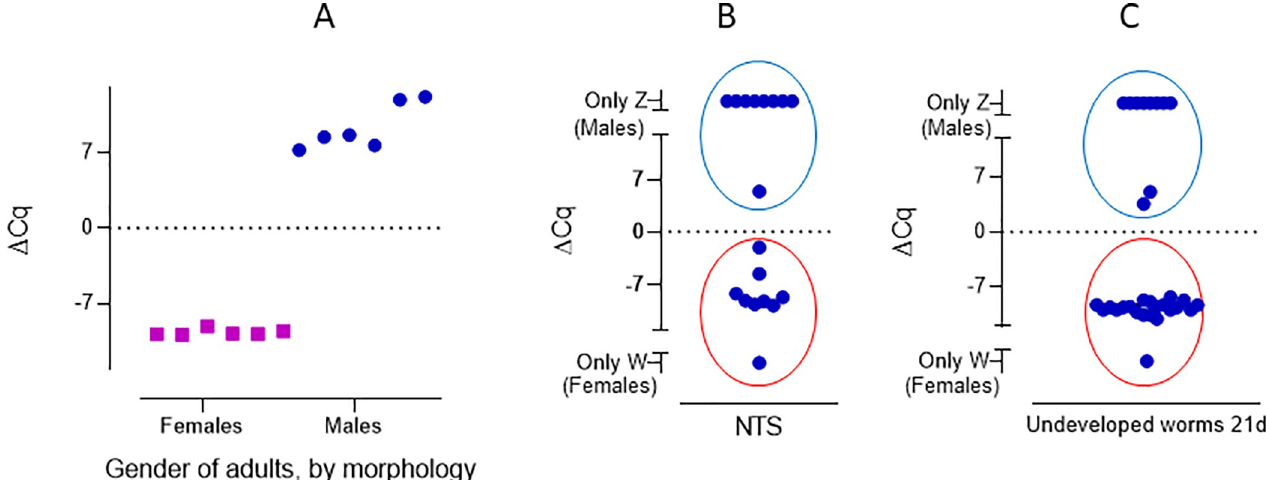
Fig 2. Comparison of the morphology and Δ Cq of adult S . mansoni (A) NTS (B) and undeveloped worms by 21 days (C). A: adult worms, collected from mice 49 days post infection, classified as females (squares) and males (circles) by morphology, compared to Δ Cq. B: gender distribution observed in NTS by means of qPCR. C: gender distribution of undeveloped worms, incubated for 21 days. The Δ Cq for female worms was negative (red circle) and positive for males (blue circle), allowing unequivocal gender identification.